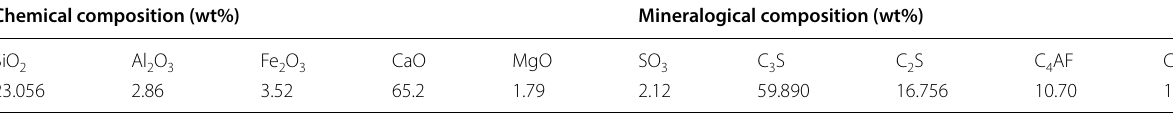
Table 1 Chemical and mineral composition of Class G oil-well cement used Chemical composition (wt%) Mineralogical composition (wt%)